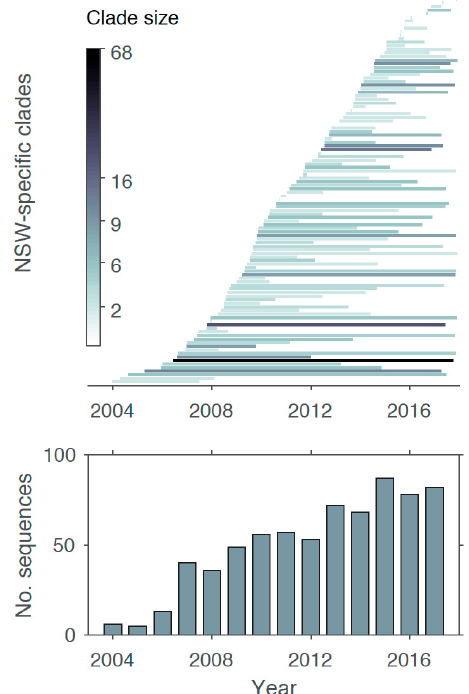
Figure 2. Sampling size changes over time. Number of sequences mapped across different years (bottom). New South Wales (NSW)-specific clade duration is shown by plotting the duration from the oldest to the most recent sequence sampled within a clade (top). Clades are colored according to clade size that represents the number of sequences within each clade.